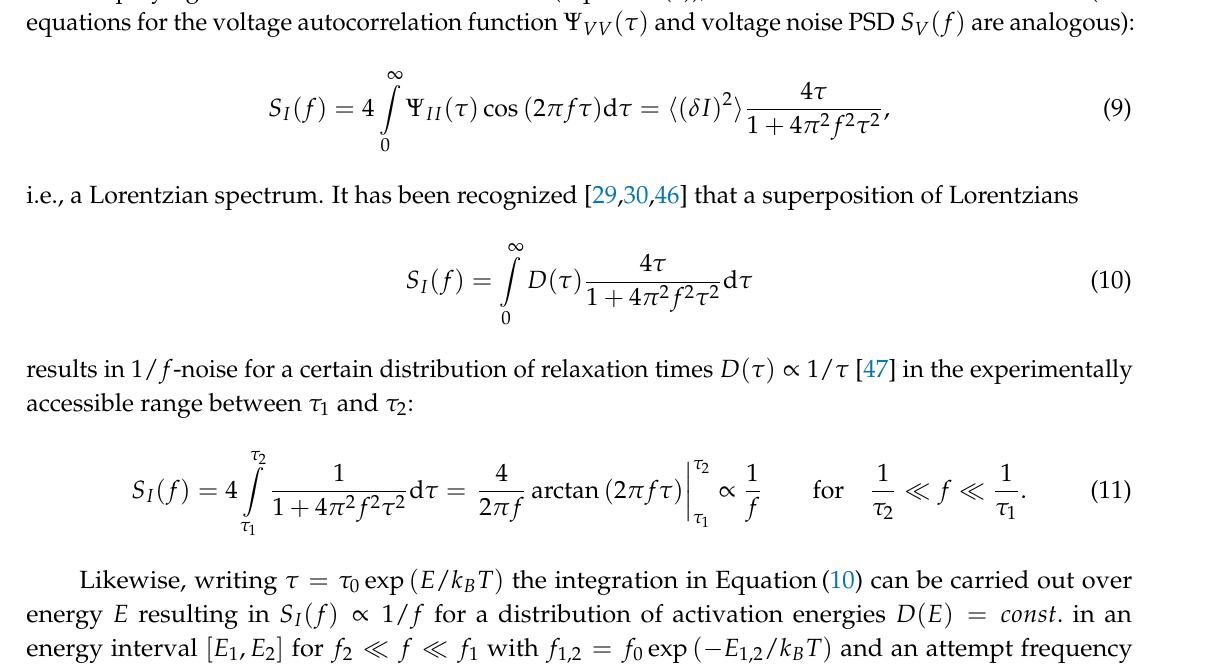
1. Reprinted with (cid:39)